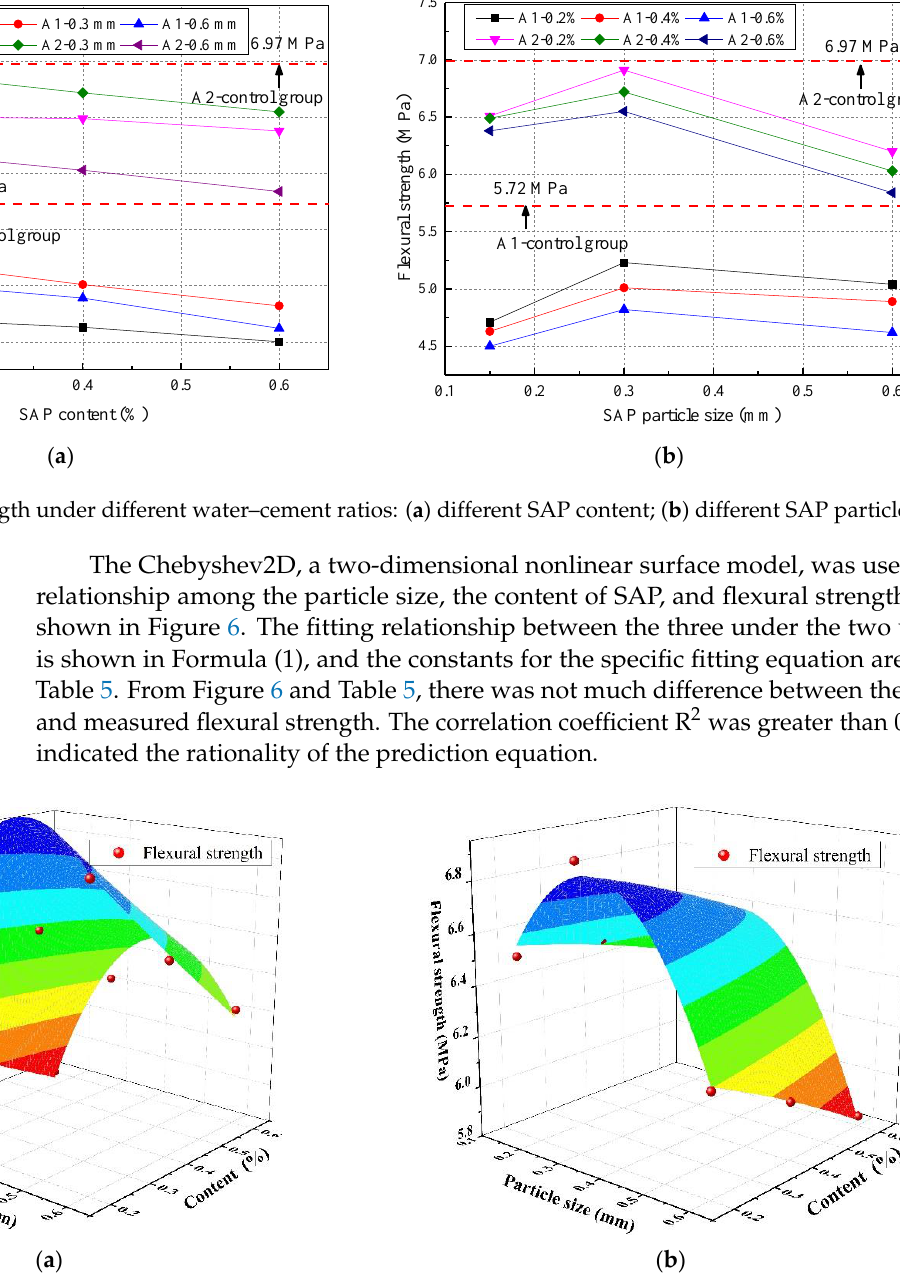
Figure 6. The relationship among SAP particle size, content, and flexural strength: ( a ) water–cement ratio of 0.3; ( b ) water–cement ratio of 0.37. Table 5. Prediction equation fitting of 28-day concrete in flexural strength.